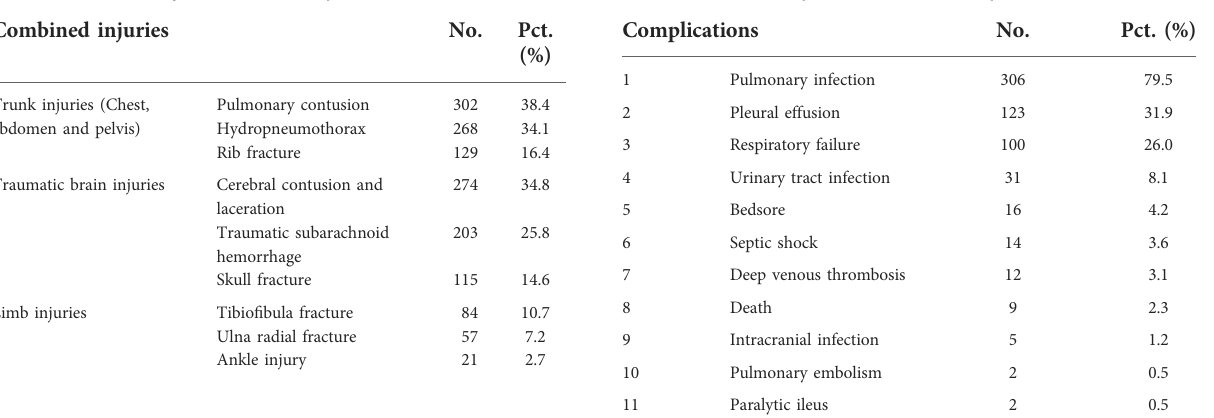
TABLE 2 Combined injuries of 787 TSCI patients.